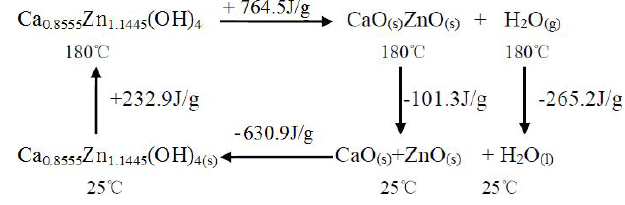
Figure 8: Dehydration/hydration cycle for Ca 0.8555 Zn 1.1445 (OH) 4 /CaO + ZnO.